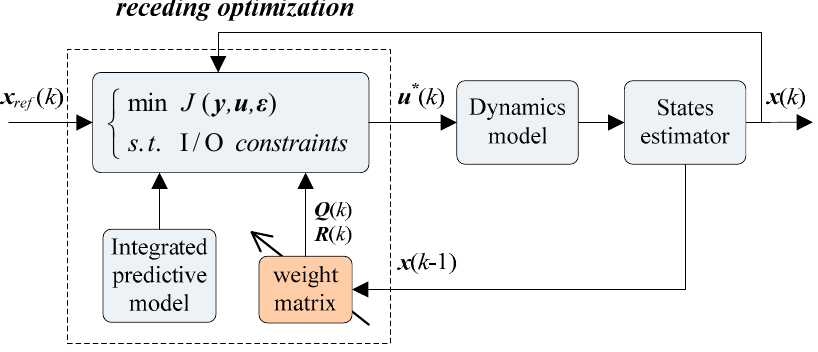
Figure 6. Schematic diagram of IACC control algorithm with tunable weight coefficients.